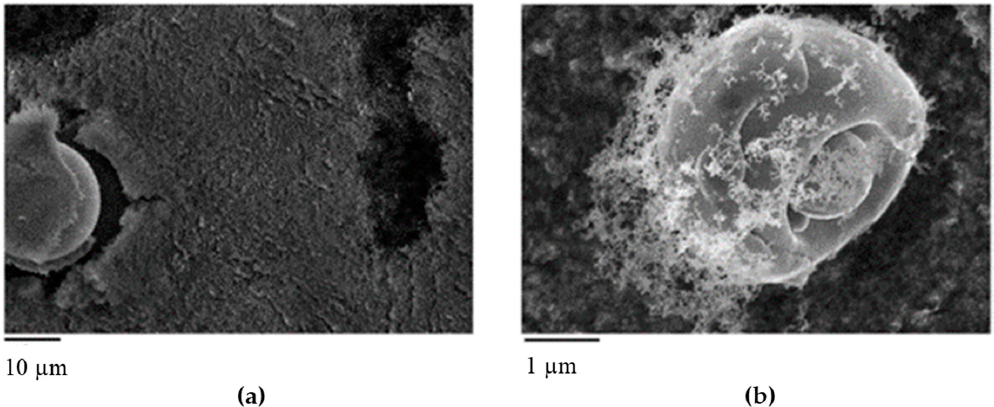
Figure 10. SEM images of condensate: ( a ) low-magnification micrograph of a sample taken from the chamber wall; ( b ) condensate deposited on a spatter particle. Reproduced from Reference [101] with permission from Elsevier.